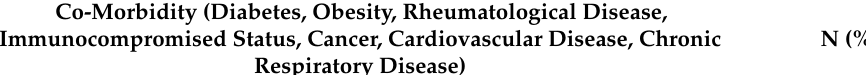
Table 2. Comorbidity, risk perception, experience of discrimination, and vaccine hesitancy of the study